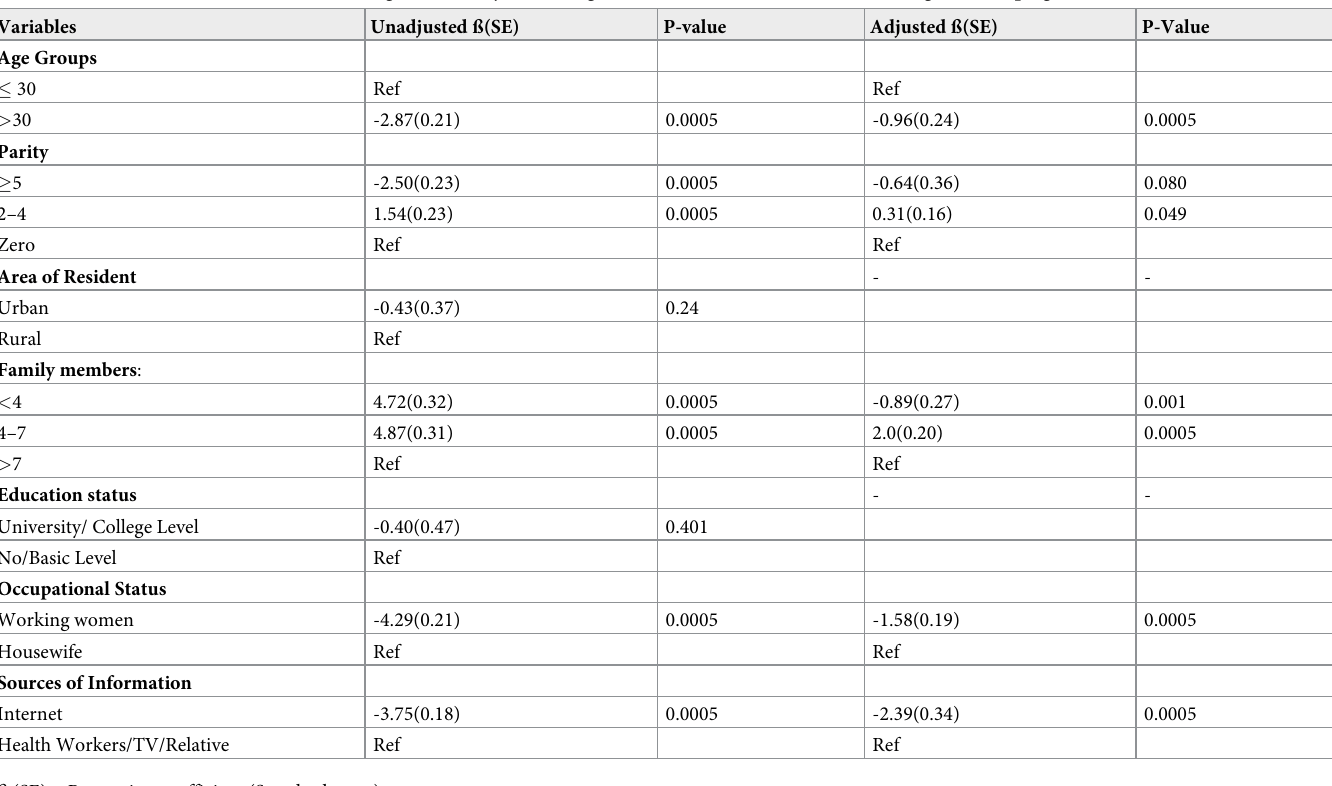
Table 4. Univariate and multivariable linear regression analysis showing the factors associated with the knowledge score of pregnant women related to